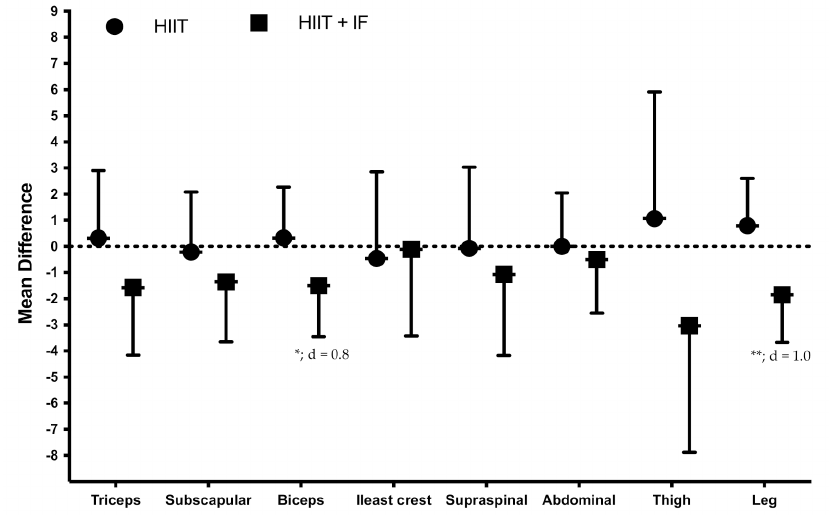
Figure 2. Effects of training on skinfolds (mm; mean difference post-training vs. pre-training: mean ± standard deviation). d, effect size; significant differences between pre- and post-training, * = p < 0.05; ** = p <